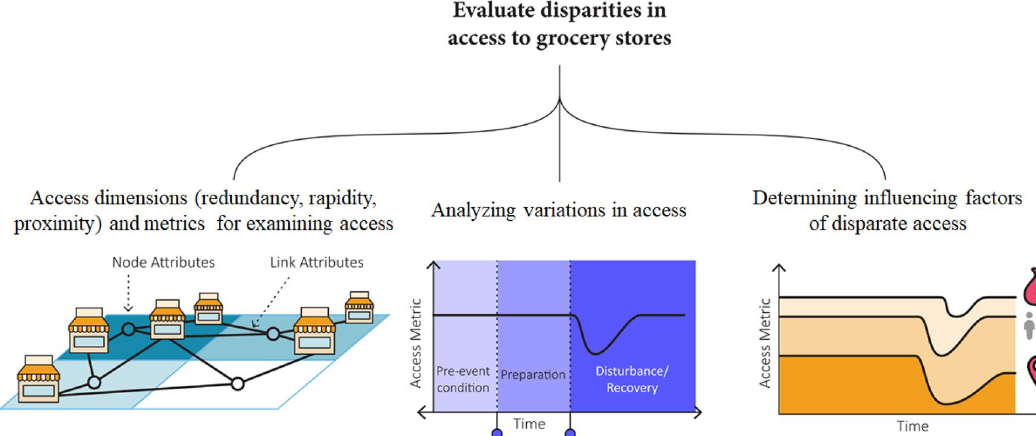
Figure 1. Framework for examining access disparities. Three dimensions of access are examined based on network-based metrics. The fluctuations in access metrics are evaluated and compared across different sociodemographic groups to assess disparities.